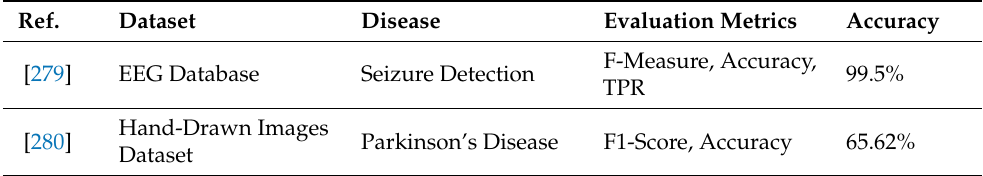
Table 19. DBM classifier result analysis on various NDs.